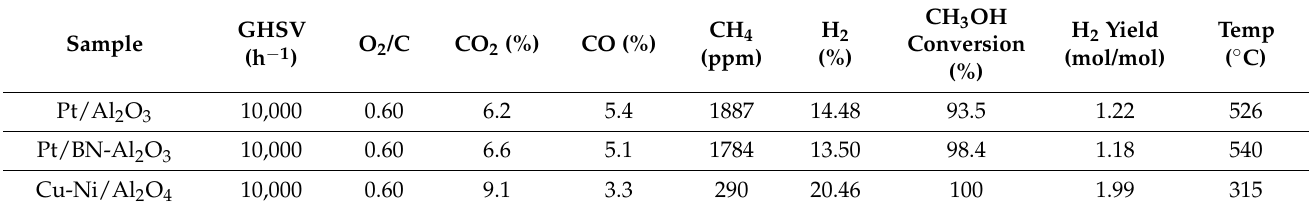
Figure 8. Temporal distributions of ( A ) MeOH conversion and temperature; ( B ) H 2 , CO, CO 2 , and CH 4 concentrations for POM. Table 2. POM test data for different